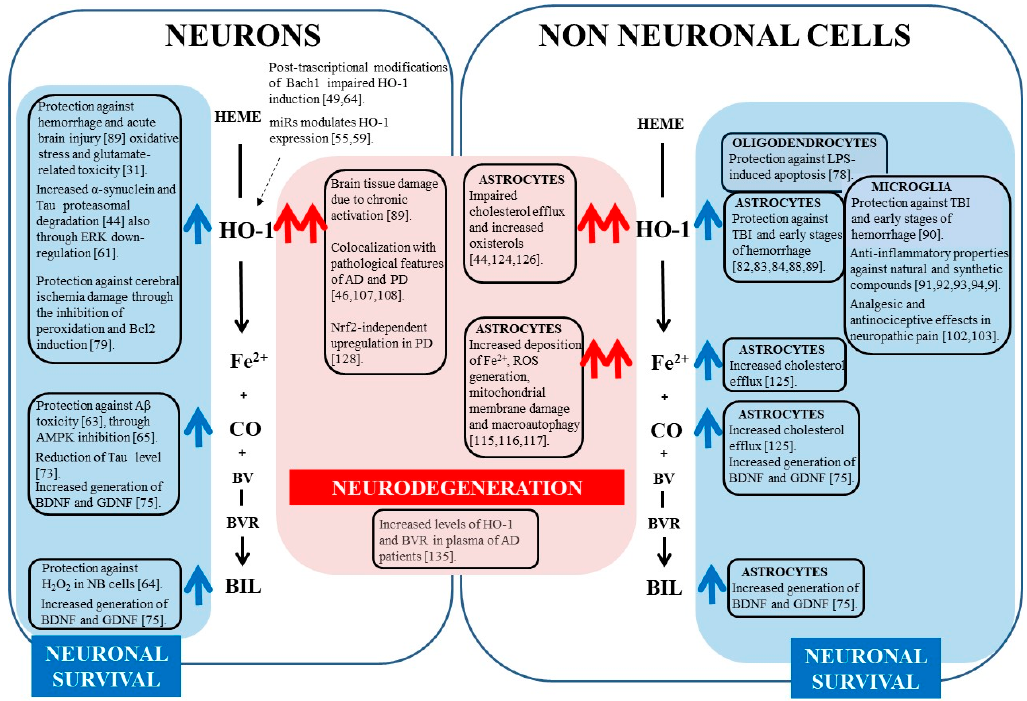
Figure 1. Schematic representation of HO-1 dependent pathway activated in neurons and in the different glial cells. The opposite outcomes (neuronal survival/neurodegeneration) are highlighted and related to the intensity of HO-1 activation and to the amount of free iron and CO generated in neurons and glial cells. The blue arrows indicate the involvement of HO-1 and its metabolic products in neuronal survival; red arrows indicate the involvement of HO-1 and its metabolic products in neurodegeneration; dashed arrow indicates the involvement of miRs in regulating HO-1 expression acting on different molecular targets.